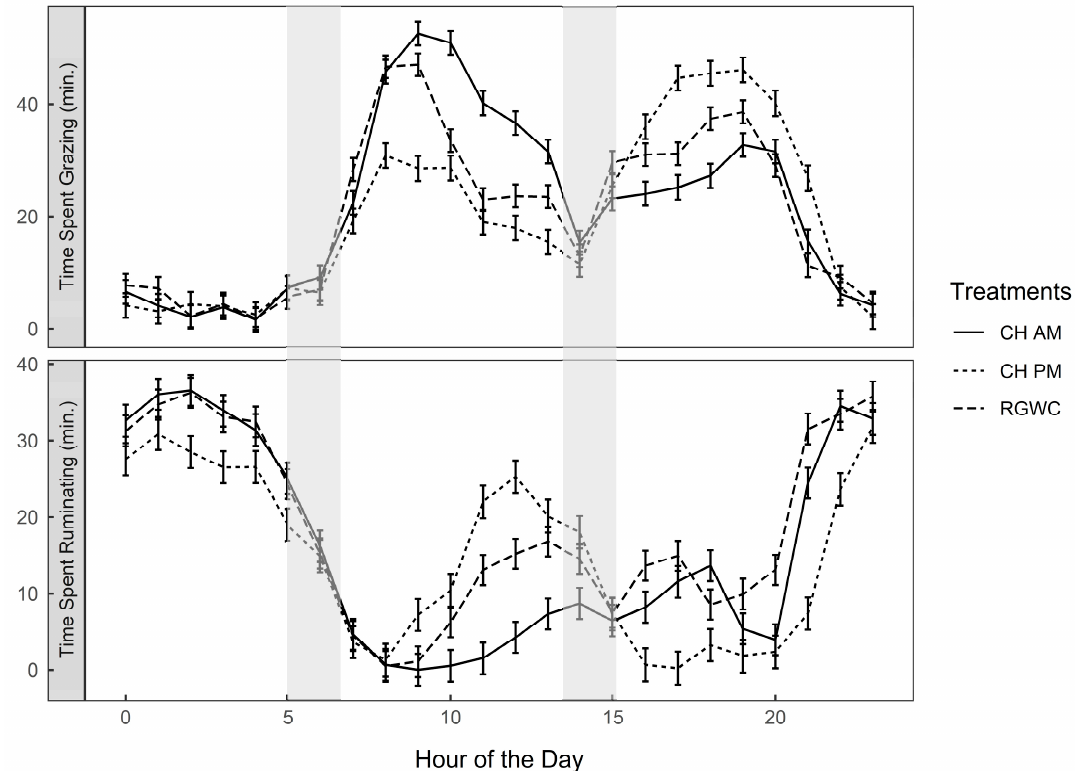
Figure 2. Diurnal variation of time spent grazing and time spent ruminating (min / h). Solid lines denote CHAM (ryegrass / white clover + morning allocation of chicory), short dashed line denotes CHPM (ryegrass / white clover + afternoon allocation of chicory), and long dashed line denote RGWC (perennial ryegrass / white clover only). Shaded areas represent AM and PM milking events. Error bars are standard error of the mean. Abbreviation; CH, chicory.